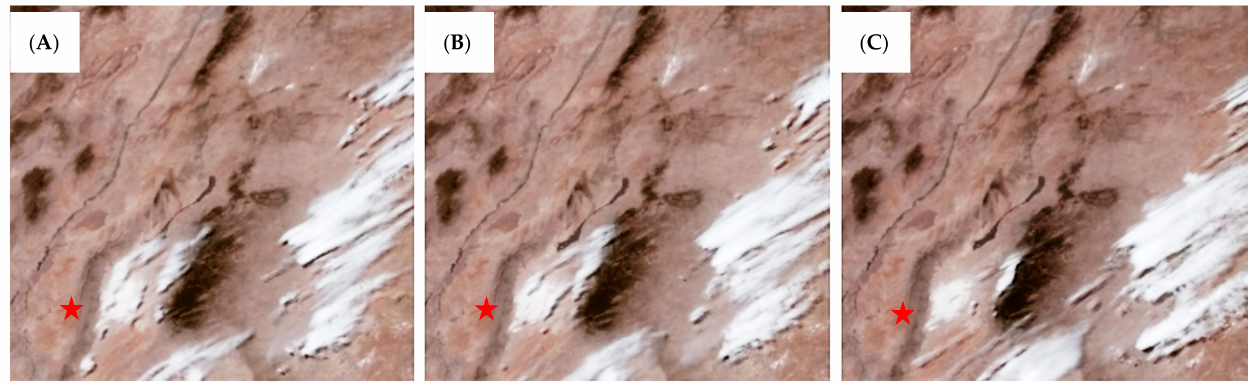
Figure 10. NOAA GOES-16 Satellite imagery, 17 April 2018 (https://rammb.cira.colostate.edu/ramsdis/online/loop.asp? data_folder=loop_of_the_day/goes-16/20180418000000&number_of_images_to_display=100&loop_speed_ms=150 (ac- cessed on 8 June 2021)). ( A ) 1730 UTC, lee wave regime. ( B ) 1800 UTC, transitional period. ( C ) 1830 UTC, LRS observed south of White Sands National Park. Red star indicates location of San Andres Mountains. Photo courtesy of CSU/CIRA and NOAA/NESDIS.